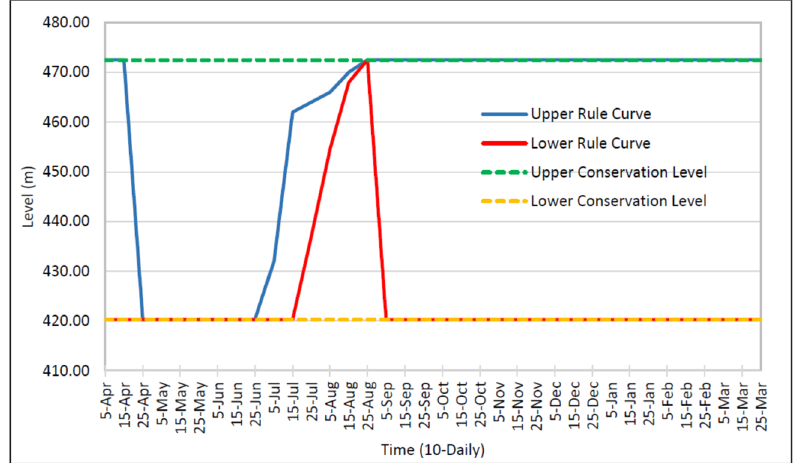
Figure 13. Tarbela Reservoir Rule curves.